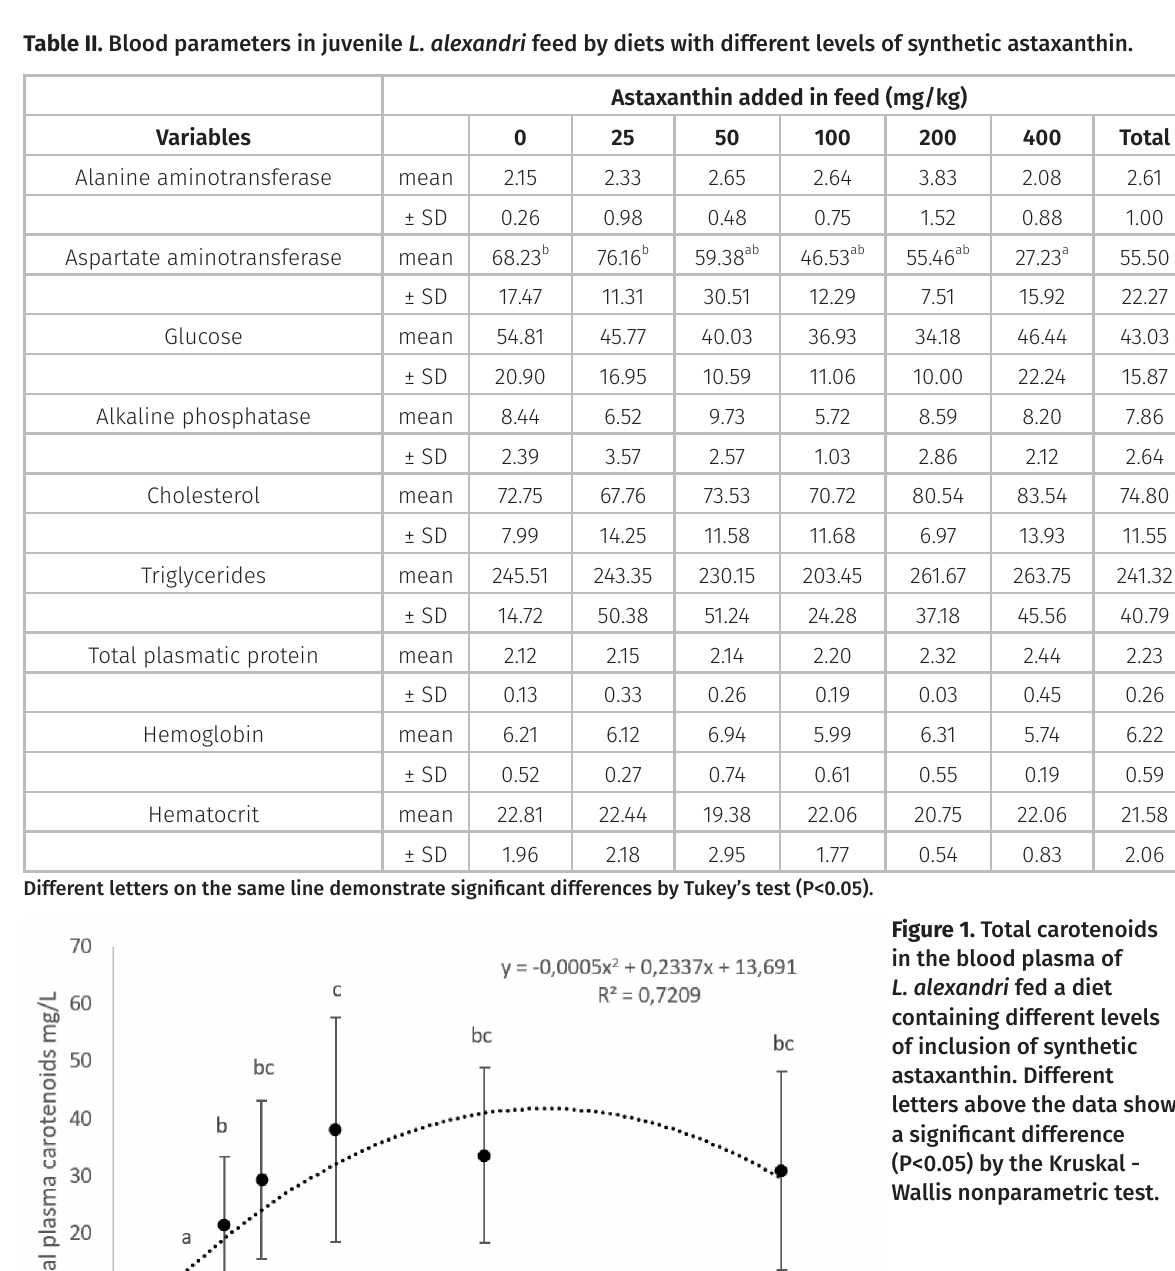
Astaxanthin added in feed (mg/kg)